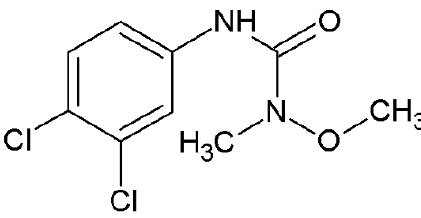
Figure 1. The chemical structure of